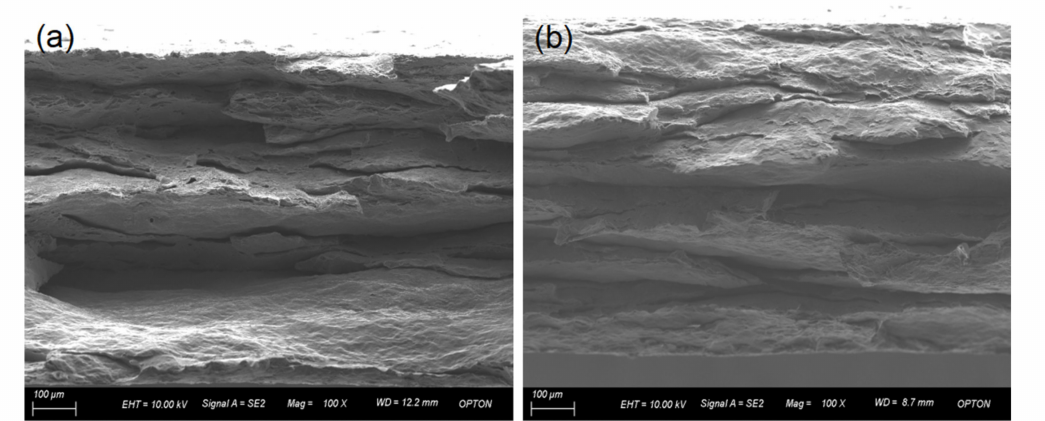
Figure 8. Fracture Surface of the composites. ( a ) EPD 4 min and ( b ) EPD 8 min.